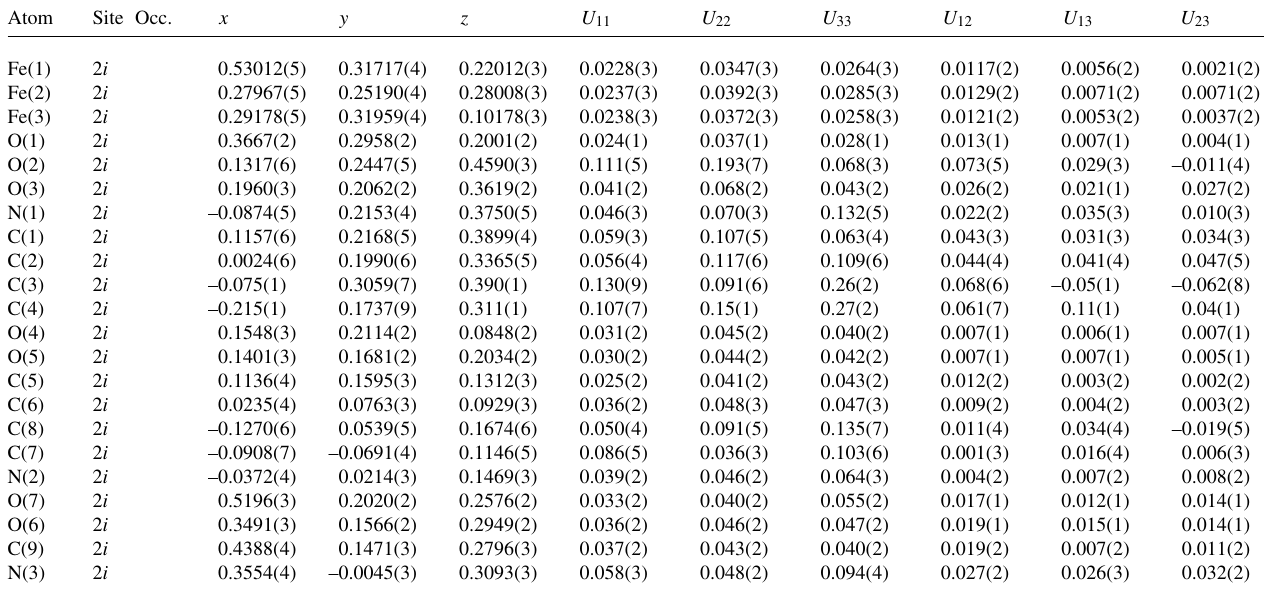
Table 3. Atomic coordinates and displacement parameters (in Å 2 ) .